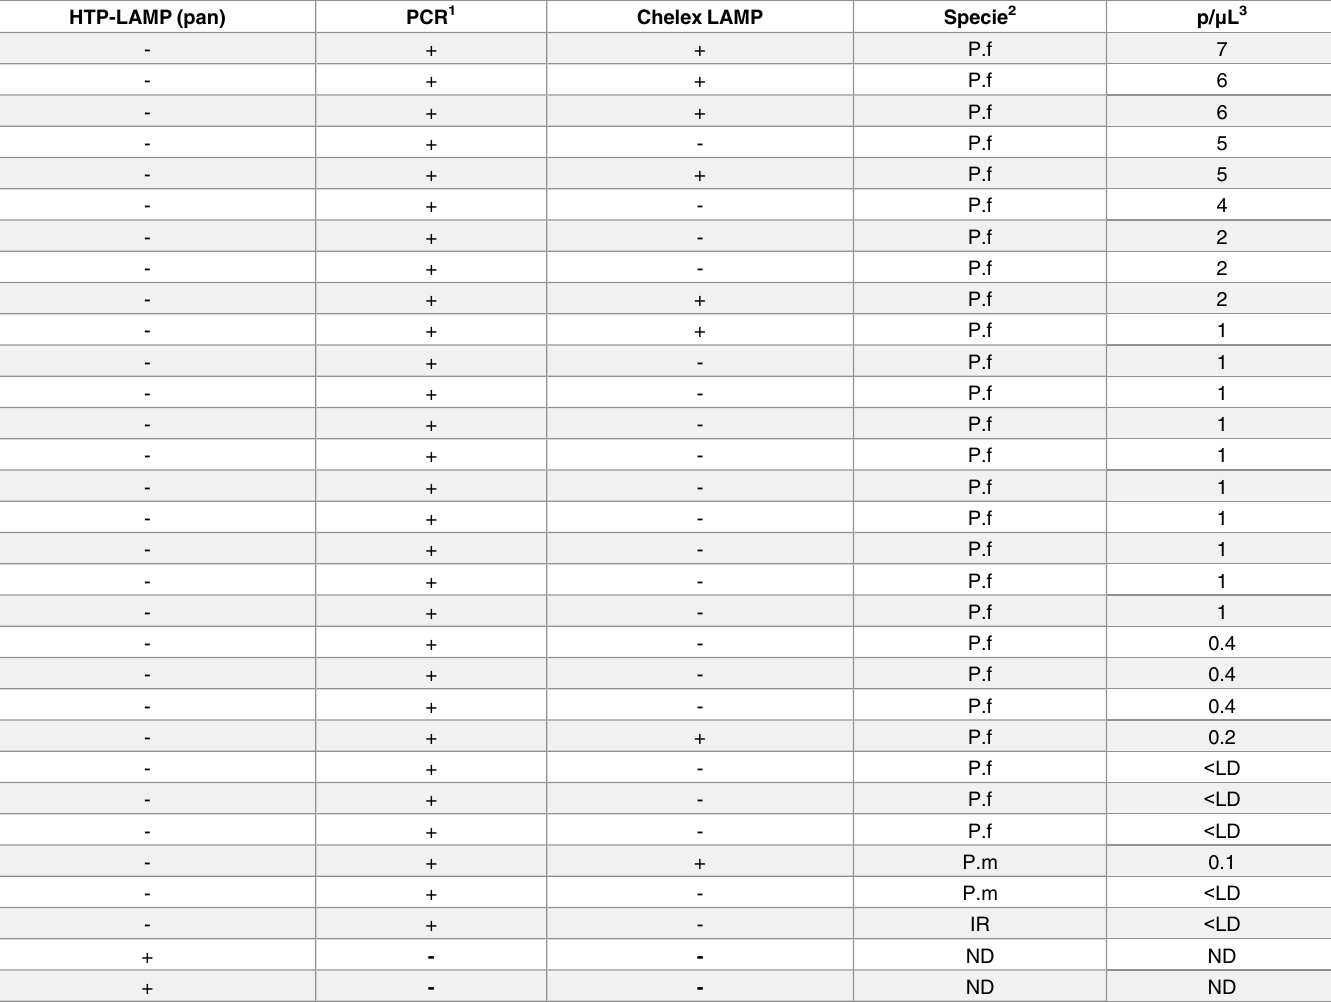
Table 2. Characterization of HTP-LAMP versus PCR discordant samples for diagnosis of Plasmodium infection (N = 31). HTP-LAMP